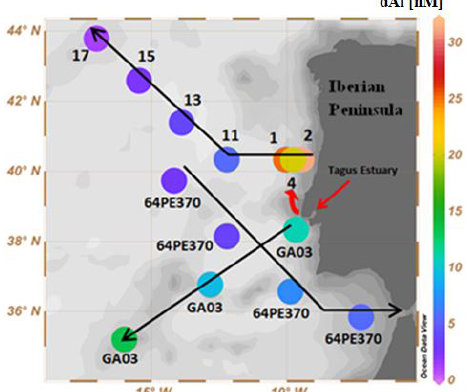
Figure 3. Surface concentration of dAl in the Iberian Basin dur- ing GEOVIDE. Label GA03 refers to GEOTRACES section GA03 (Measures et al., 2015); 64PE370 refers to GEOTRACES section GA04N (Rolison et al., 2015). Black arrows show the cruise tracks. Red arrows show the location of the Tagus estuary and the north- ward direction of the Tagus plume. Plot created in Ocean Data View (Schlitzer, 2018).